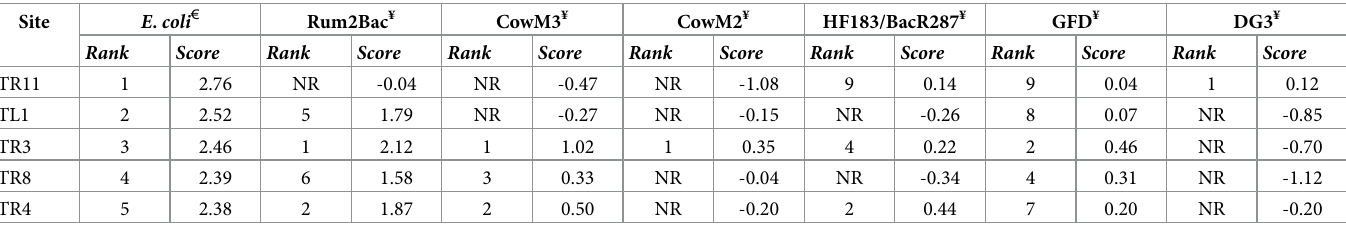
Table 2. Top five sites with highest average E . coli log 10 MPN/100mL concentrations and respective fecal source identification site rankings by qPCR assay.